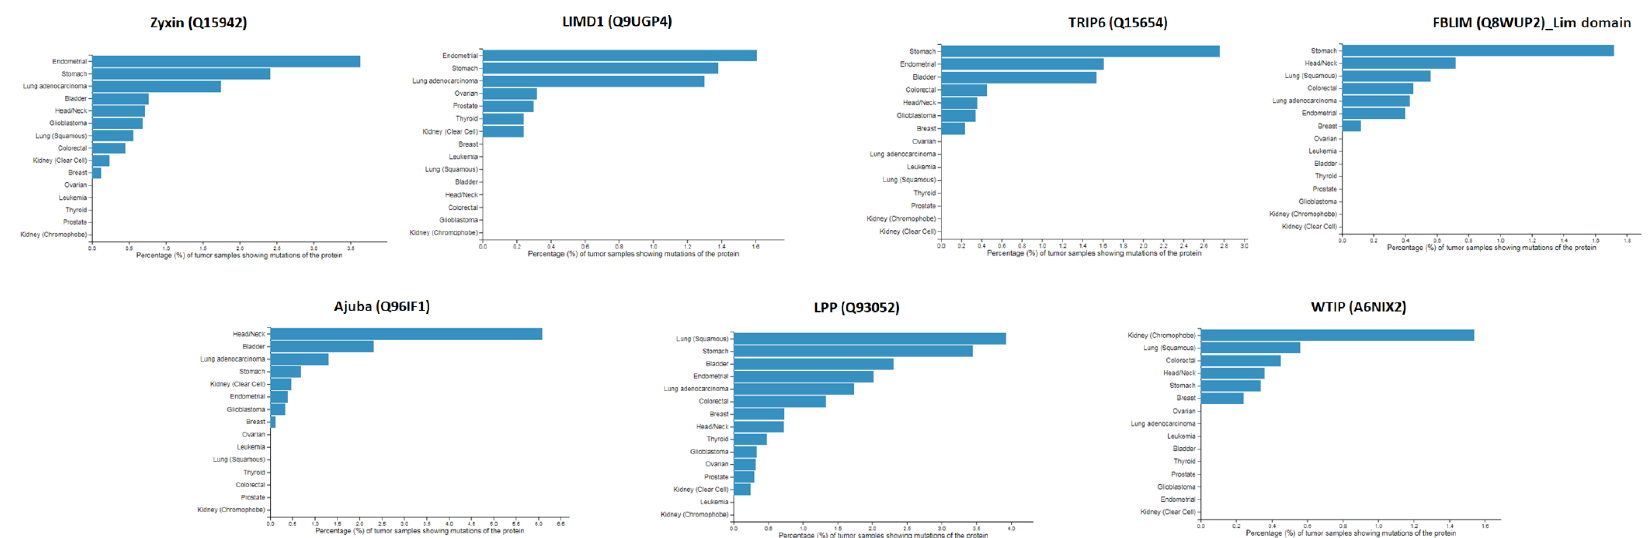
Figure 6. Mutational frequency profiles of the Zyxin family proteins with different cancer malignancies. All proteins exhibit a considerable amount of mutational frequency which varied for each member. The highest mutation frequency was observed for Ajuba and the lowest was observed for LIMD1.